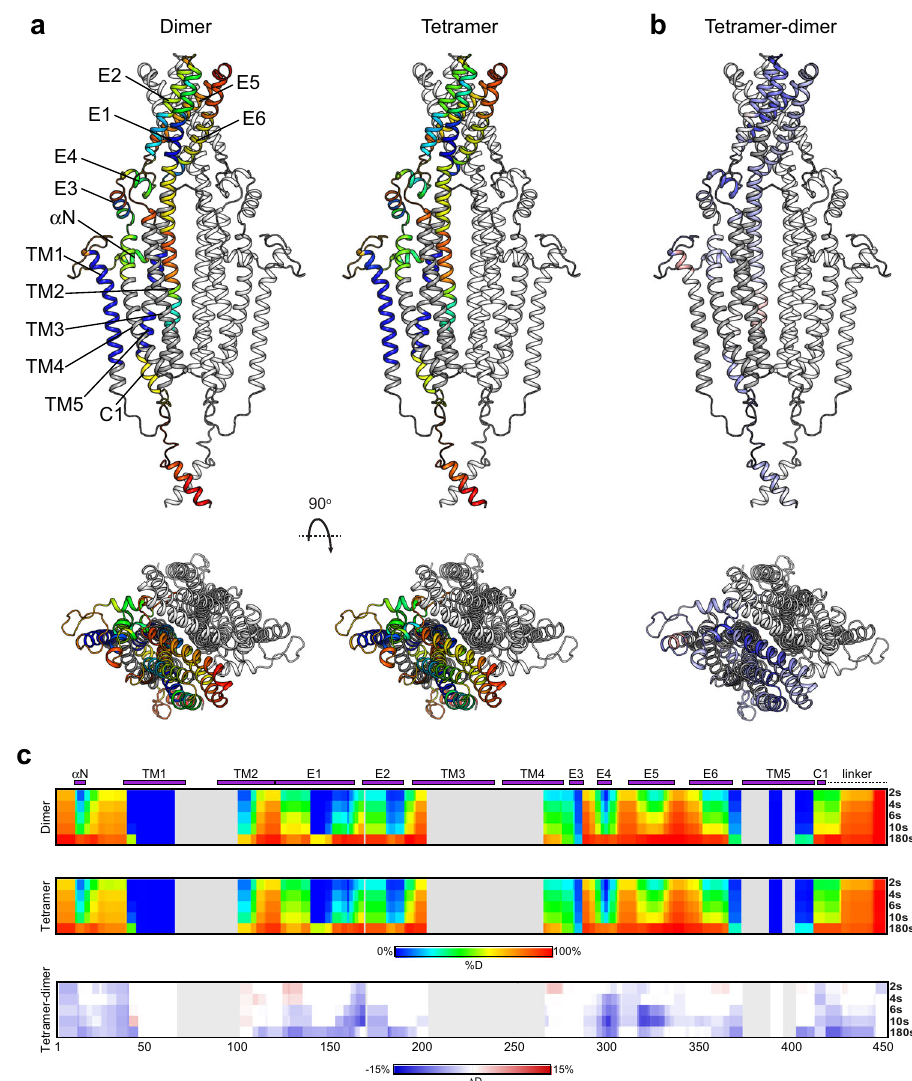
Fig. 4 HDX-MS analysis of mTTYH1. a Cartoon representations of mTTYH1 homology model. A single chain is colored as a heat map, representing the HDX level following 10 sec (s) incubation in D 2 O for the dimeric (left) and tetrameric (right) populations. The highest and lowest exchange levels are indicated in red and blue, respectively. b The HDX difference between the tetrameric and dimeric populations, following 10 s incubation in D 2 O, is mapped onto the mTTYH1 homology model. c Deuteration levels at the indicated time points for the dimer (upper panel) and tetramer (middle panel). The difference between the tetrameric and dimeric populations is shown (bottom panel). The secondary structure elements are indicated above the heat